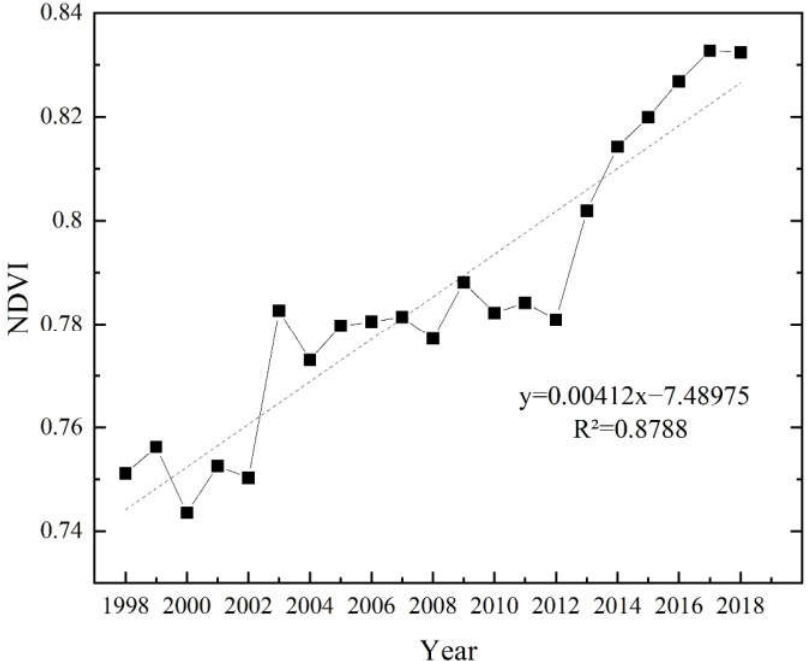
Figure 2. The trend of average NDVI from 1998 to 2018.